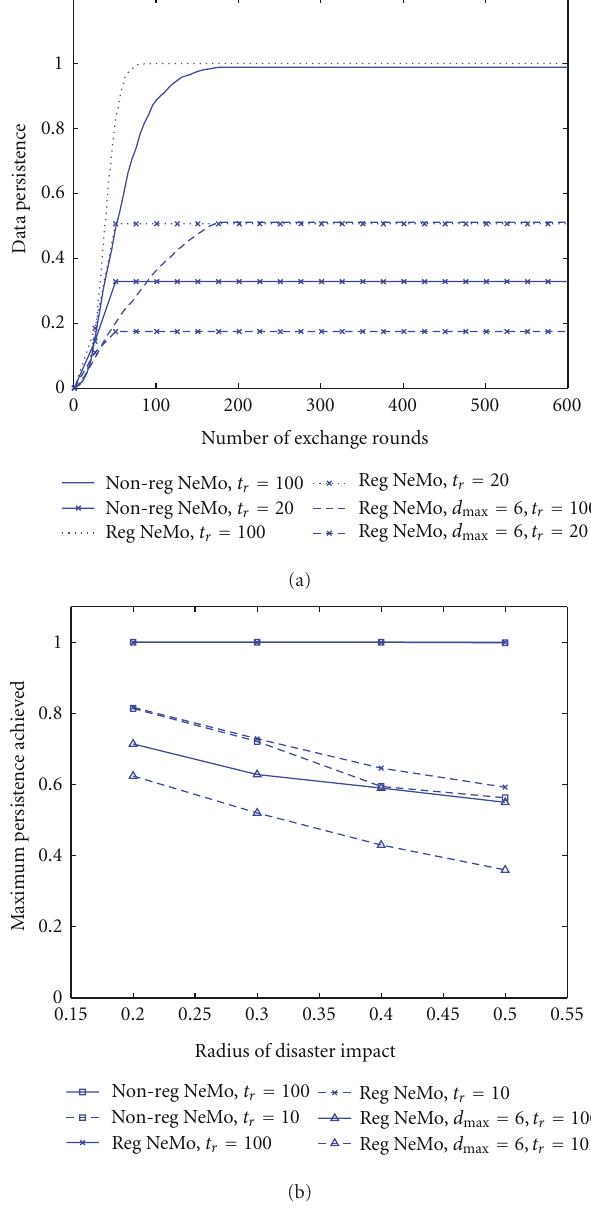
Figure 9: (a) Random failure when t r = 20 and 100; (b) Regional failure when t d = 10 and